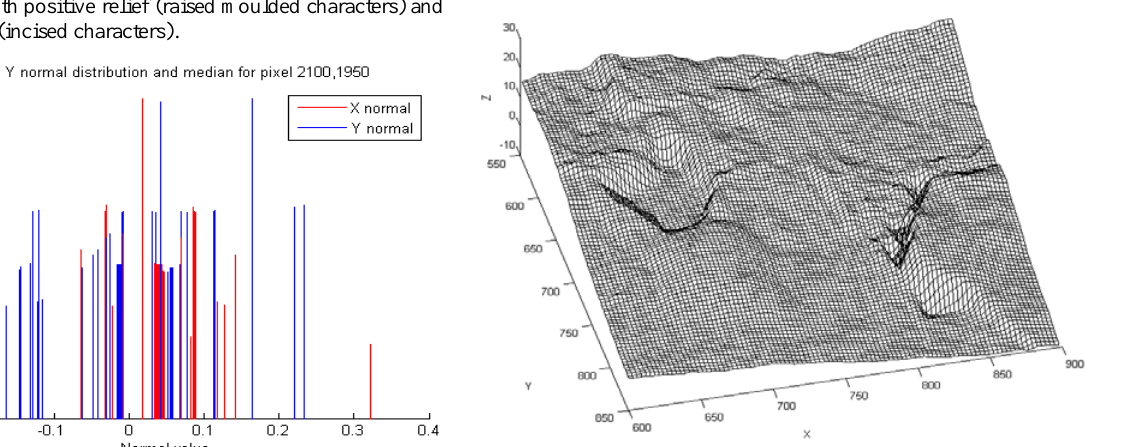
Figure 14. Reconstructed surface of 300x300 pixel